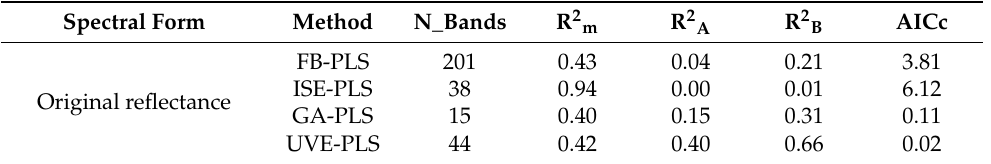
Table 3. PLSR model performance in estimating LNC from spectra within 400–1400 nm with different band-selection methods. The number of bands (N_bands) used in each PLSR model and the coefficient of determination values for the simulation dataset (R 2 m ), dataset A (R 2 A ), and dataset B (R 2 B ) are shown in the